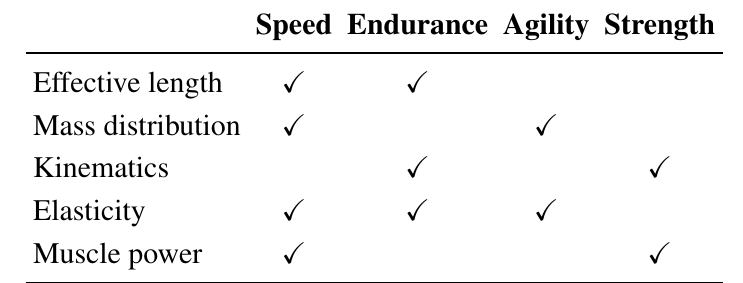
Table 2. Key elements and their influence on desired characteristics of horse